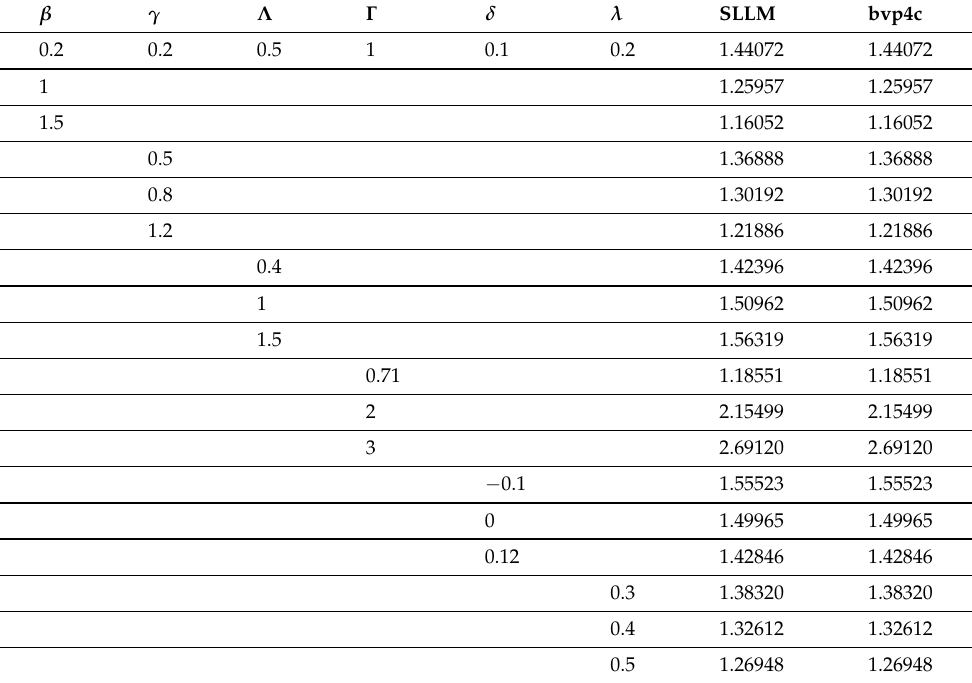
Table 5. Numerical comparison between present method and bvp4c for Nusselt number against different values of the other